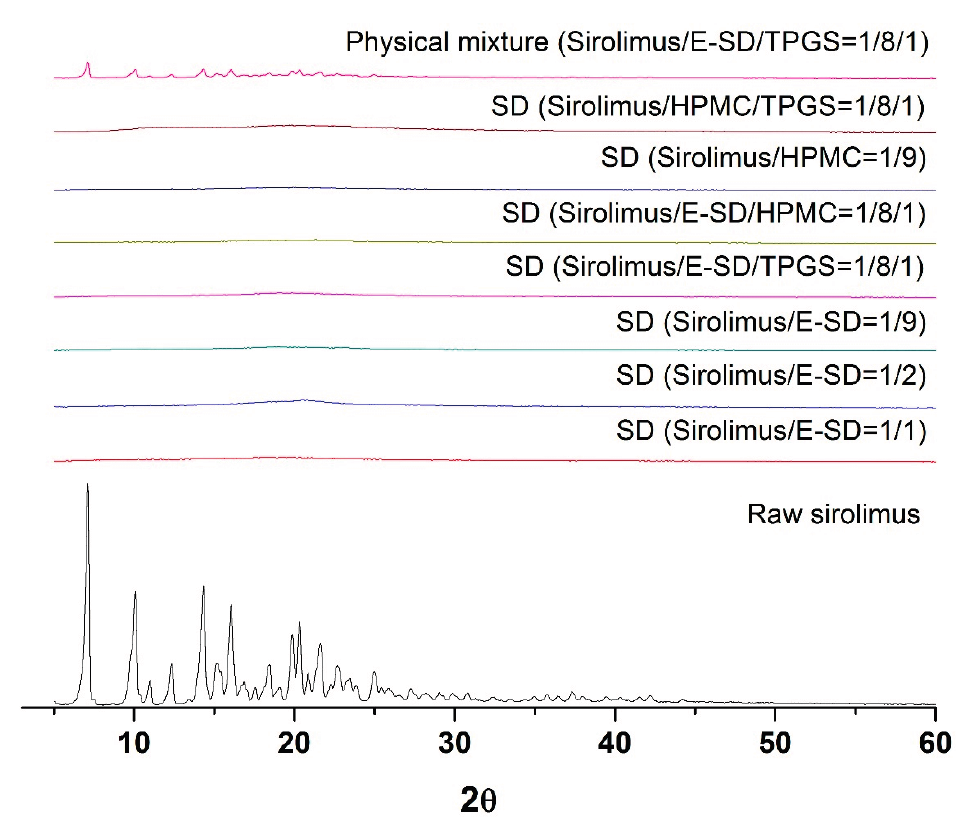
Figure 3. Powder X-ray diffraction patterns of sirolimus-loaded solid